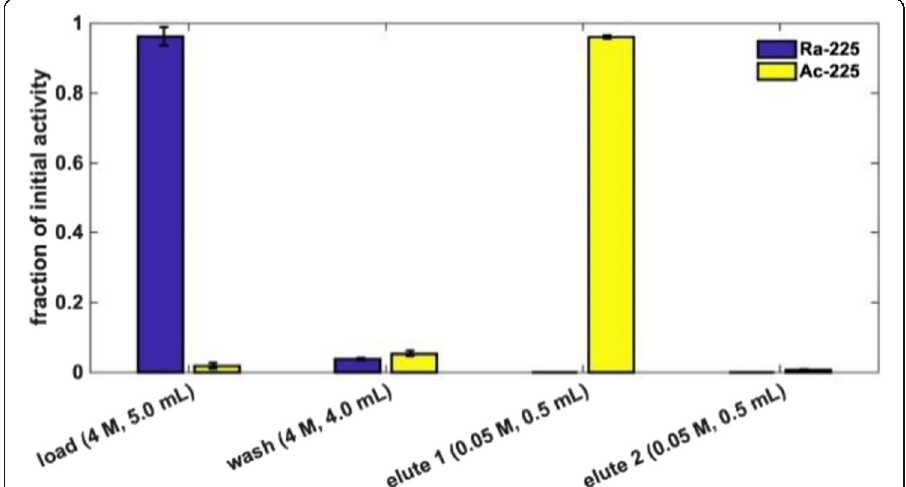
Fig. 3 Representative elution profile for 225 Ra/ 225 Ac separation on DGA branched resin in nitric acid